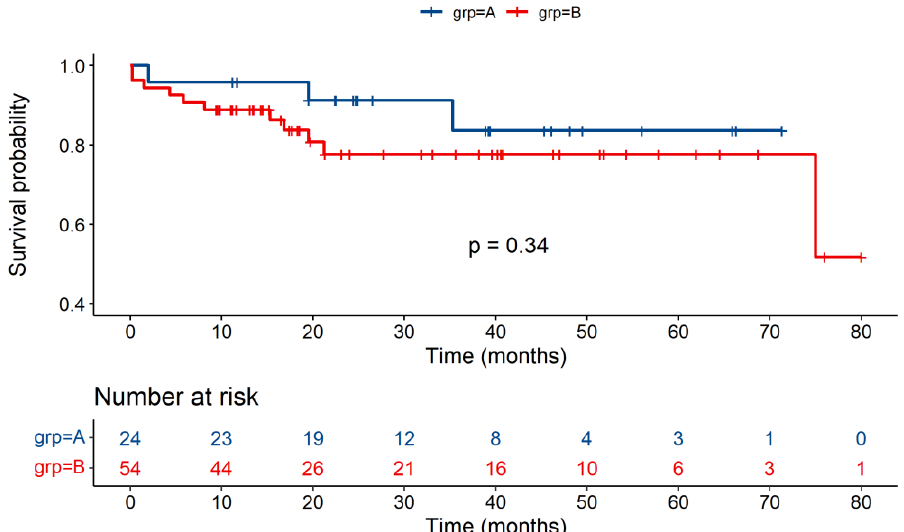
Figure 3. Overall Survival of Recipients in Group A and Group B. Kaplan–Meier estimates of sur-